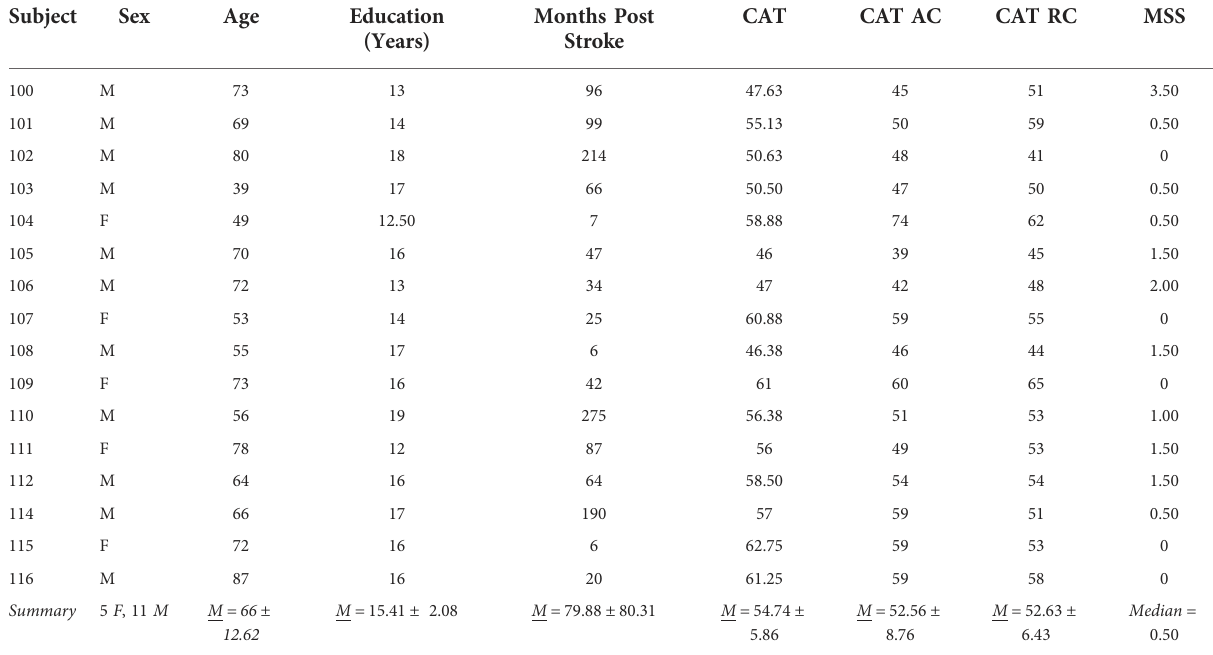
TABLE 1 Participant demographic information.